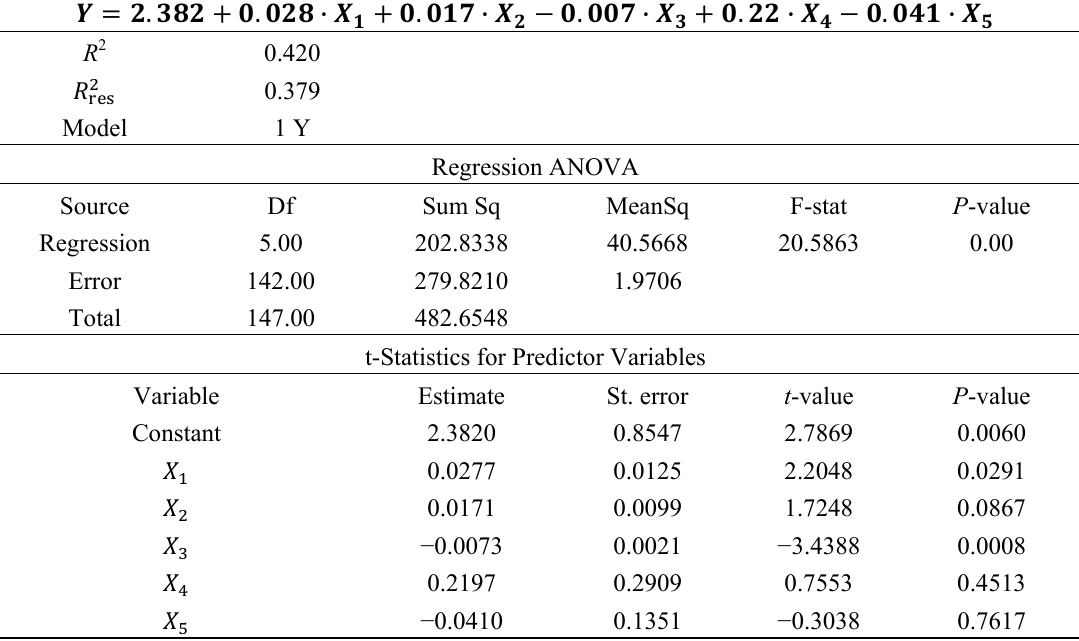
Table 6. ANOVA results for Model 1Y of Table